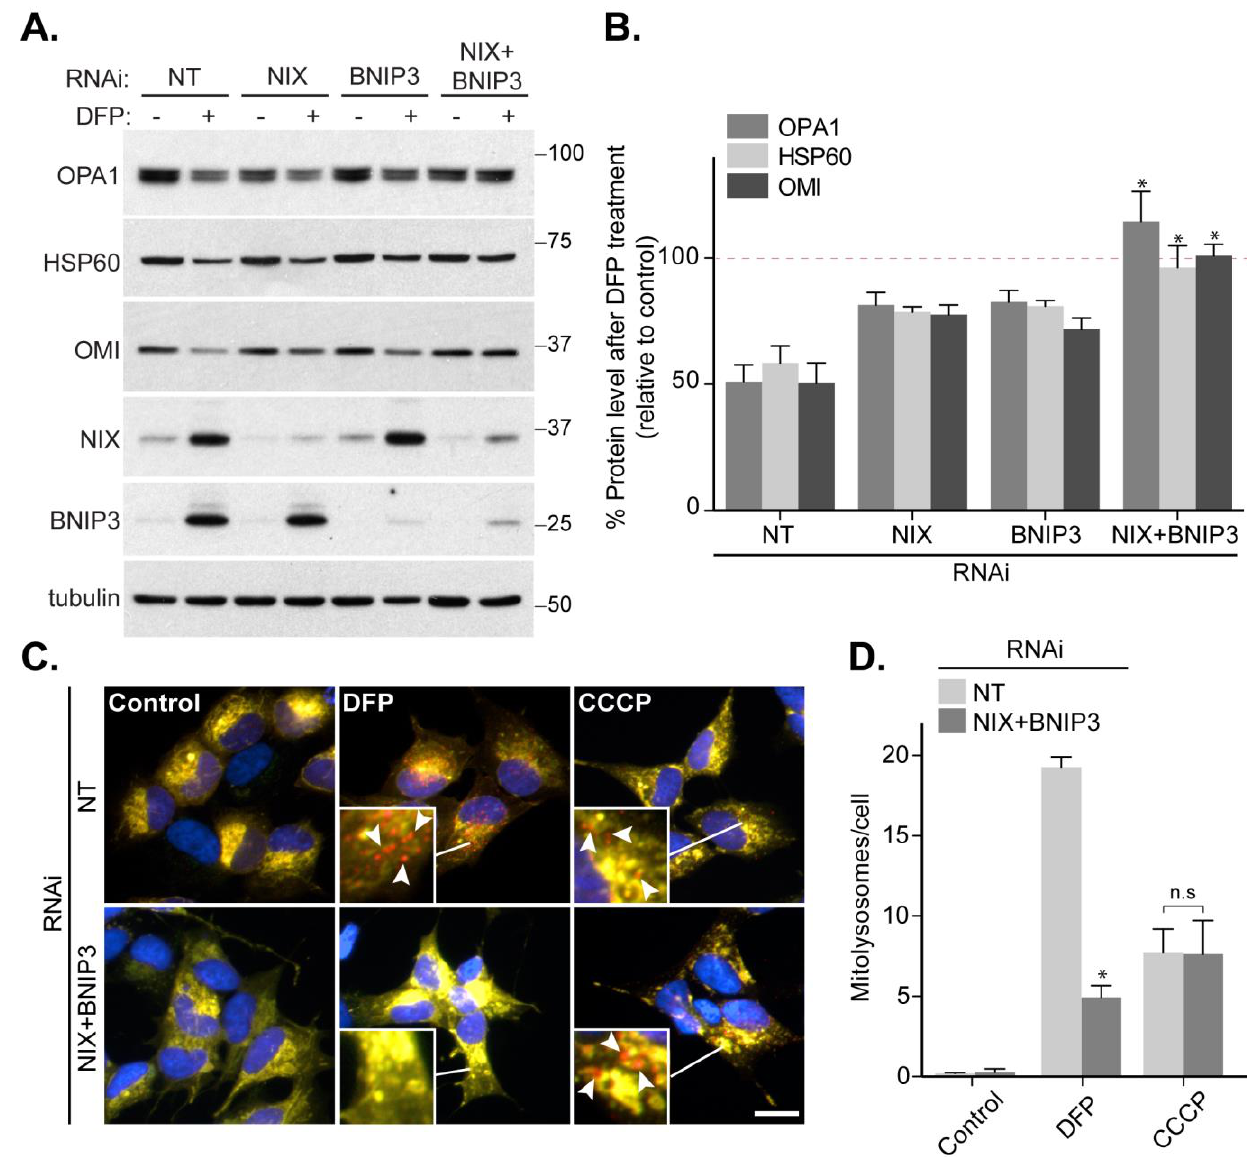
FIGURE 2: NIX and BNIP3 redundancy in DFP-induced mitophagy. (A) Control SH-SY5Y cells or SH-SY5Y cells stably expressing BNIP3 shRNA were either transfected with non-targeting (NT) siRNA or NIX siRNA. 48 h post-transfection cells were treated with 1 mM DFP for a further 24 h. (B) Quantitation from (A) of OPA1, HSP60 and OMI levels relative to control condition. Dotted line represents control value (100%). (C) Control SH-SY5Y cells were transfected with NT siRNA and SH-SY5Y cells stably expressing BNIP3 shRNA were transfected with an equal amount of NIX siRNA. Cells were treated with 1 mM DFP or 20 μM CCCP for 24 h. Arrows highlight examples of mitolysosomes. Scale bar, 10 μm. (D) Quantitation from (C) of mitolysosomes per cell as indicated. All quantitative data are mean ± SEM from 3 independent experiments. * P < 0.05, n.s, not